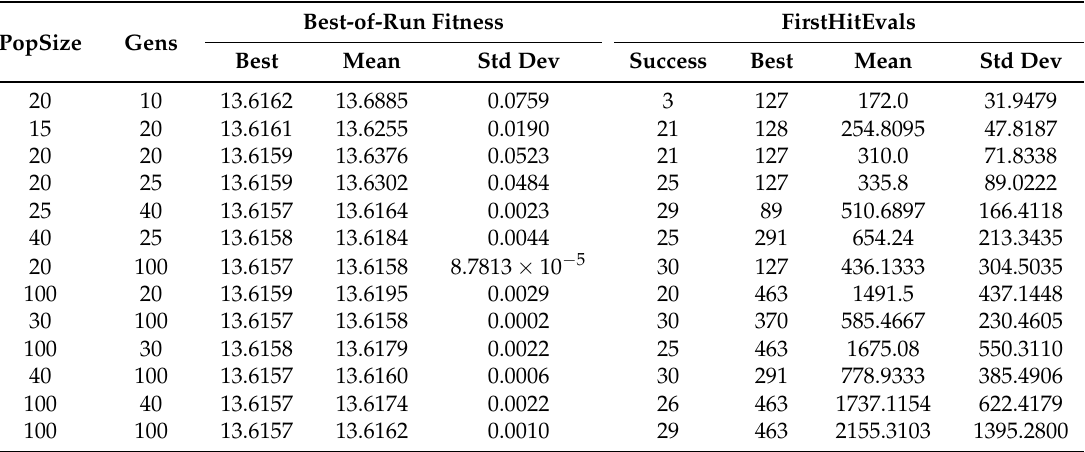
Table 8. Results of SJaya on the fuel cell problem (each row corresponds to 30 independent runs). Most numbers are shown with rounding at the fourth place after the decimal.